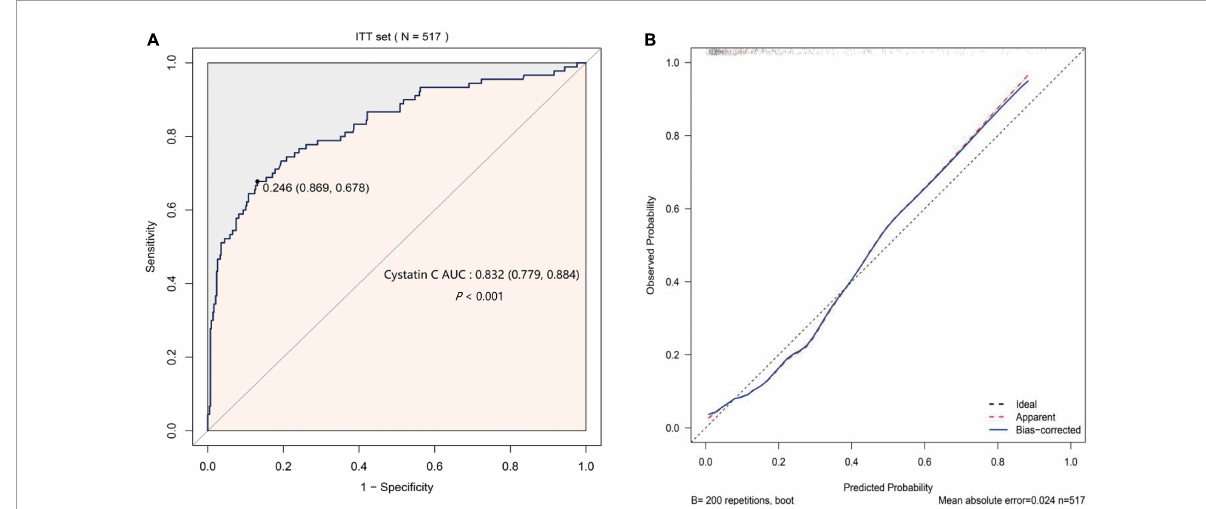
FIGURE3 The predicted validation of serum cystatin C (S-CysC) in the Intention-To-Treat set with all values feature selection ( n = 517). (A) The receiver operating characteristic curve of single S-CysC. (B) The calibration curve of single S-CysC on the delayed graft function (DGF) prediction. The ideal line showed the ideal estimated probabilities correspond to the actual observation; the apparent red line showed the predictive capability of the model; the bias-corrected blue line showed the predictive stability of the bootstrap corrected model. The apparent red line and the ideal dotted line had no significant different by Hosmer–Lemeshow test ( P = 0.142), suggesting a well fit between the model and the ideal data. The apparent red line well coincided with bias-corrected blue line illustrated the stability of the prediction of S-CysC on DGF.